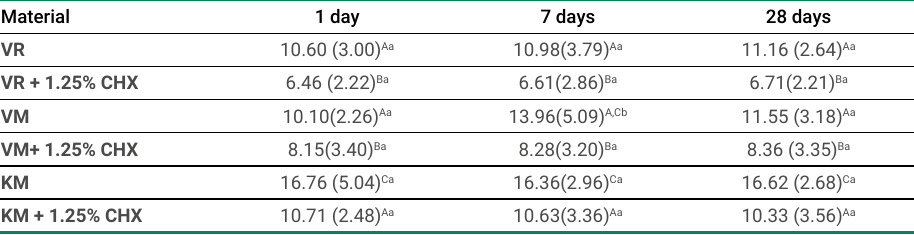
Table 4. Comparison of means (standard deviations) in MPa of compressive strength for the glass ionomer cements containing or not 1.25% CHX at different storage times. Material